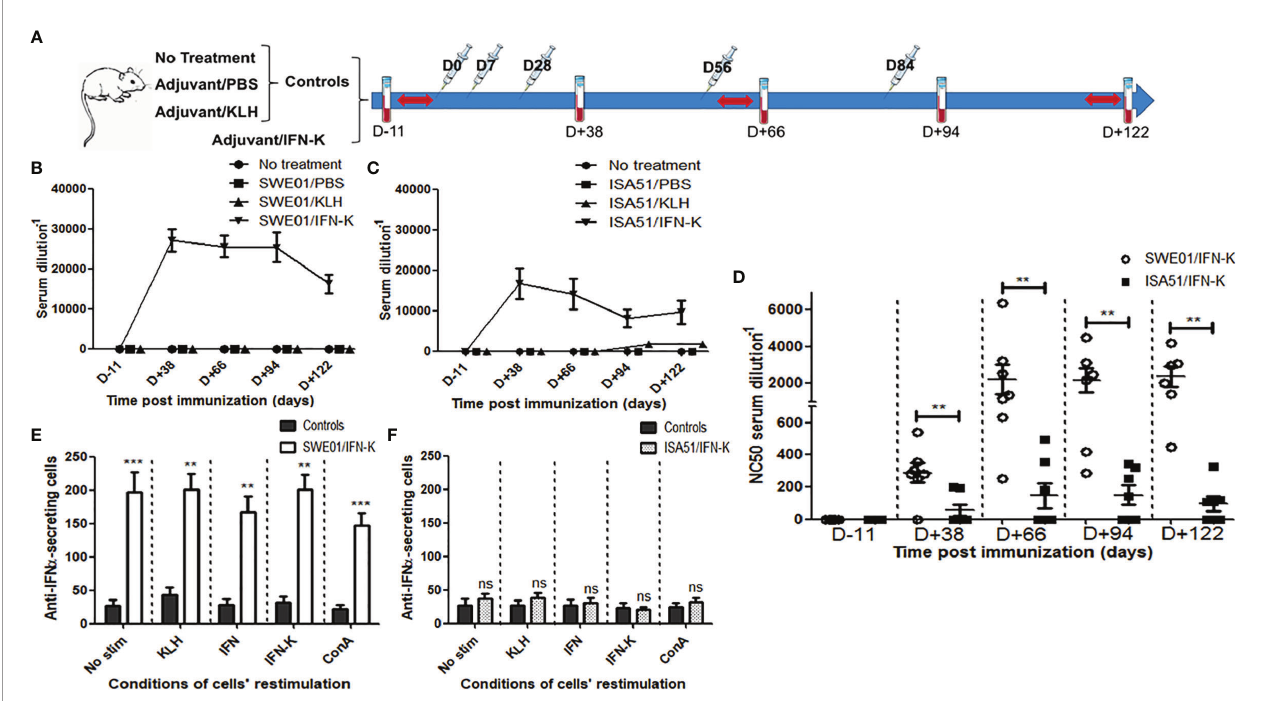
FIGURE 1 | Immunological effects of IFN-K. (A) Within each cohort (n=26; SWE01 or ISA51), 8-week-old female MRL/lpr mice were not treated (n=6) or injected (syringes) with PBS (n=6) or KLH (n=7), referred to as Controls, or treated with IFN-K (n=7) depending on their group. Blood samples (blood tubes) were collected and Sjögren ’ s syndrome-like disease (red arrows) was monitored, once prior and serially after injections for a 122-day-follow-up. (B, C) Serum anti-IFN a Abs (ELISA) and their (D) anti-IFN a neutralizing capacity were monitored at different time points pre (D-11) and post-immunization (D+38, D+66, D+94, D+122) in all groups: no treatment (n=6 +6), SWE01/PBS (n=6), ISA51/PBS (n=6), SWE01/KLH (n=7), ISA51/KLH (n=7), SWE01/IFN-K (n=7) and ISA51/IFN-K (n=7). Neutralizing activity was expressed as the serum dilution resulting in 50% neutralization of virus-mediated cell mortality (NC50). (E, F) Mononuclear splenocytes were isolated in all living mice (n=14 in SWE01- adjuvanted control mice, n=6 in SWE01/IFN-K mice, n=18 in ISA51-adjuvanted control mice and n=7 in ISA51/IFN-K mice) at sacri fi ce (D+122), and used for the quanti fi cation of anti-IFN a -IgG-producing cells. Proliferation of the harvested cells was stimulated under different conditions (no stimulation, ConA, KLH, IFN a or IFN-K, at a fi nal concentration of 10 µg/ml), without noticeable impact. Error bars indicate mean ± S.E.M. Ns, **p < 0.01 and ***p <